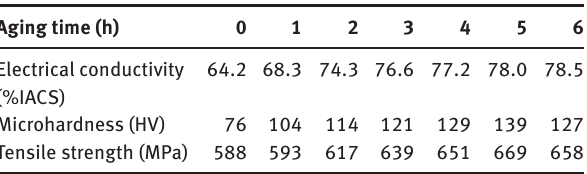
Table 1: Properties of the composite by aging at 400 ° C without cold deformation.